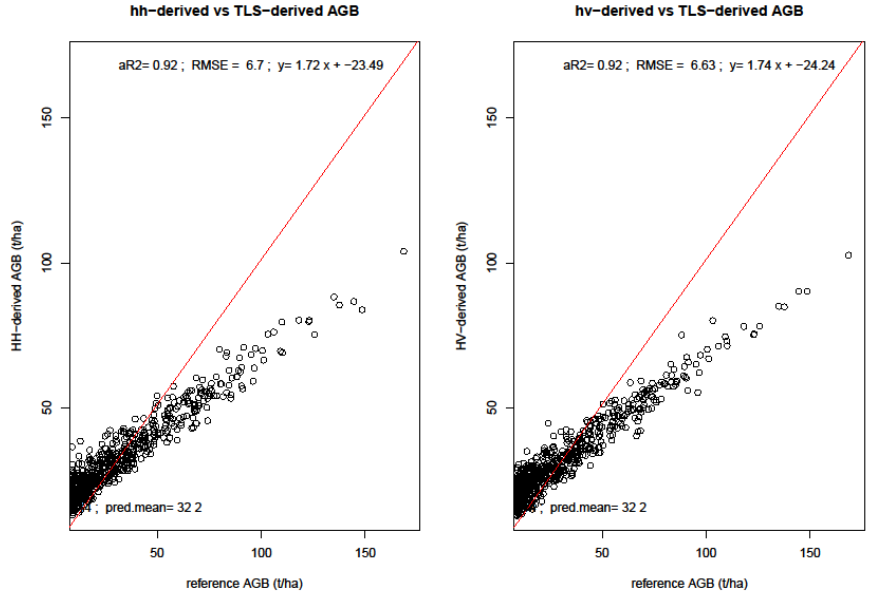
Figure 12. Correlation between SAR ‐ derived biomass and reference TLS ‐ metrics derived biomass. The graphs show co ‐ and cross polarized L ‐ band ALOS derived AGB responses.